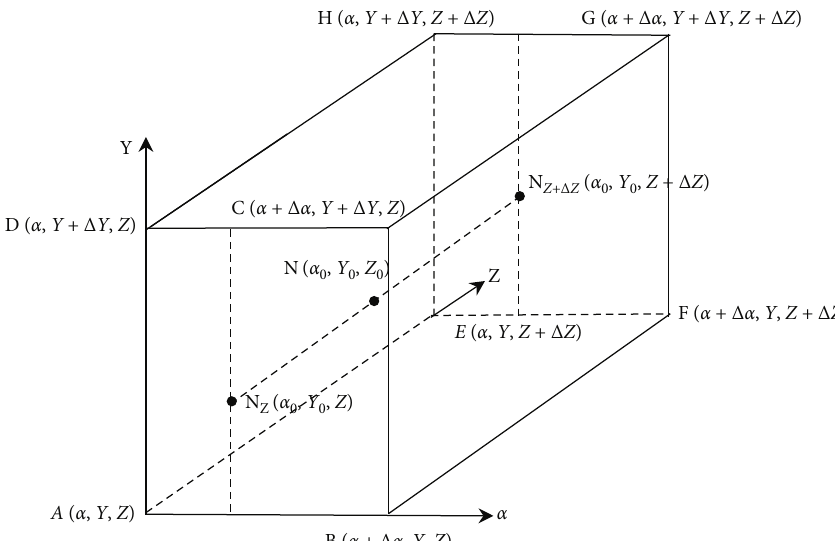
Figure 7: Simplified interpolation element of the aerodynamic